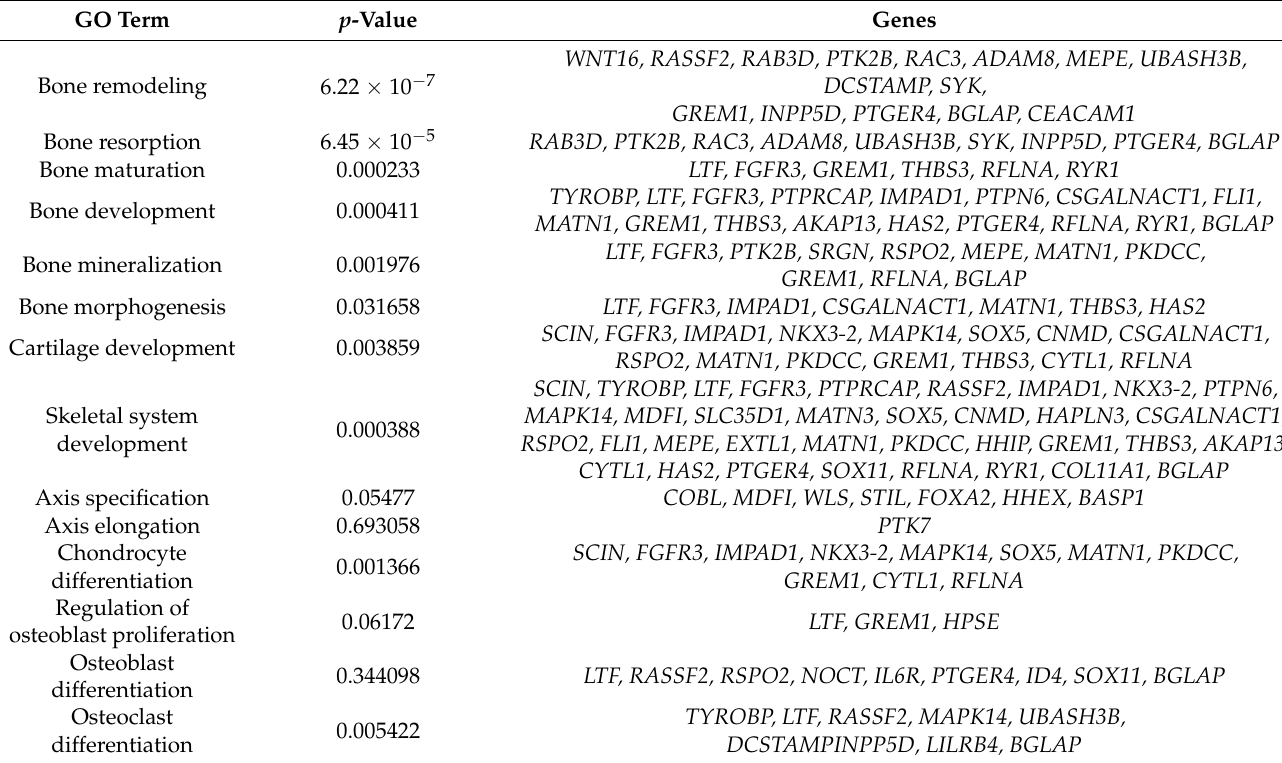
Table 2. Significant GO terms and the functional genes associated with bone